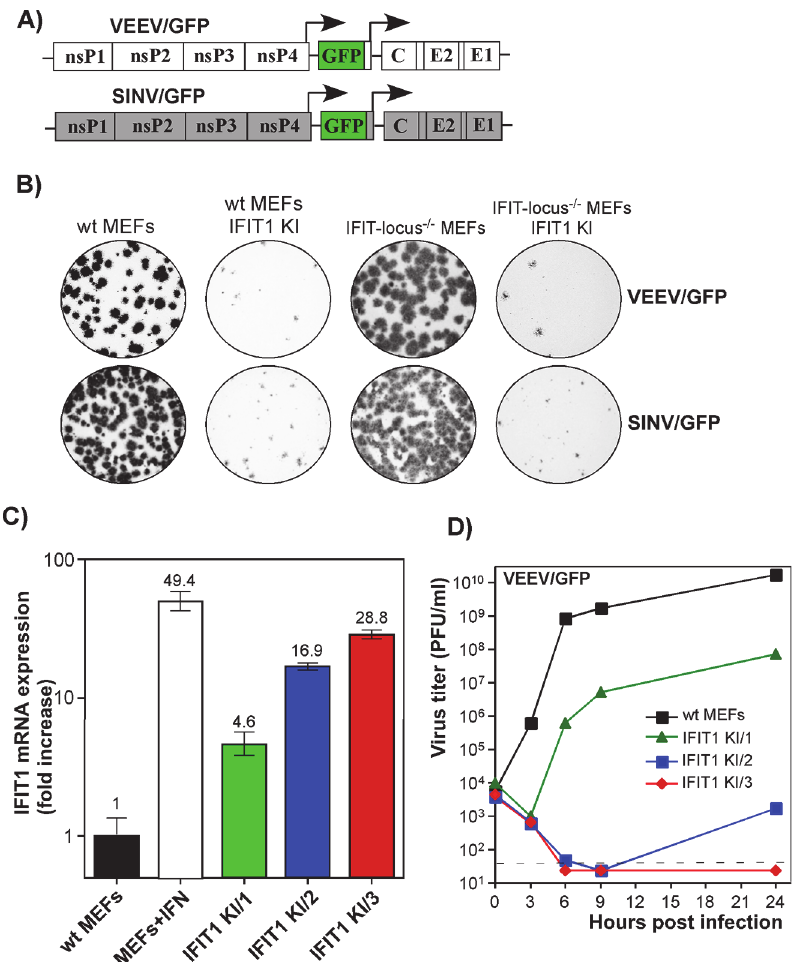
Fig 7. IFIT1 inhibits replication of alphaviruses in a concentration-dependent mode. (A) The schematic representation of the genomes of alphaviruses used in the experiments presented in this figure. (B) Populations of Bla R , IFIT1-expressing and parental cells were used for standard plaque assay of VEEV/GFP and SINV/GFP viruses. Since both viruses were unable to induce plaque formation on stable IFIT1-expressing cells, foci of GFP-expressing cells were detected on a Typhoon phosphorimager. (C) The results of RT-qPCR analysis of IFIT1-specific mRNA in different clones of IFIT1 KI cells, derived from wt MEFs, which were used in the experiments presented on the next panel and in the following sections. (D) The indicated clones of IFIT1 KI cells were infected at an MOI of 1 PFU/cell with VEEV/GFP. Media were replaced at the indicated time points, and virus titers were determined by plaque assay on BHK-21